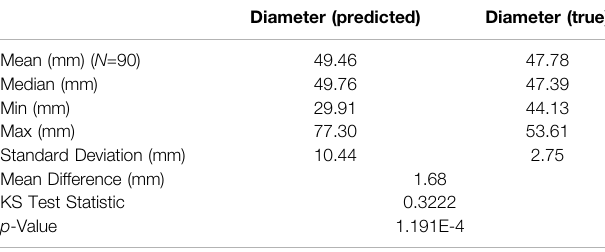
TABLE 4 | Kolmogorov-Smirnov test results for the medium class.